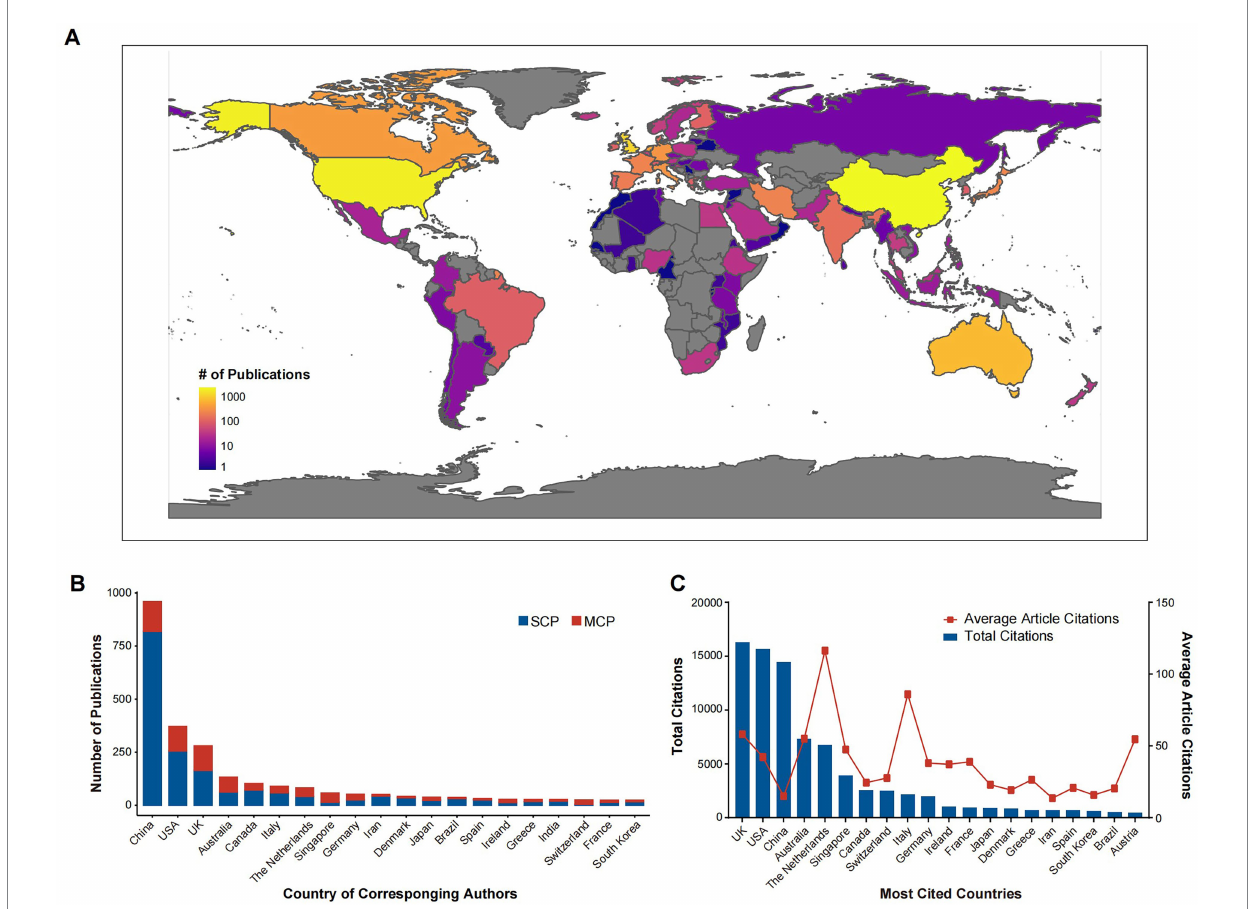
FIGURE 3 Country production and citation. (A) A heat map is presented displaying the number of publications from different countries according to the occurrence of authors. (B) Corresponding author’s country. (C) Top 10 cited countries. SCP, single country publication; MCP, multiple country